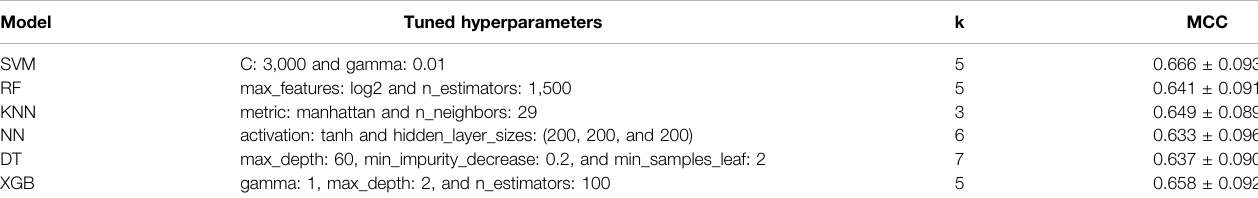
TABLE 2 | Tuned hyperparameters, k in the SMOTE, and the training performance of six machine learning models. Model Tuned hyperparameters k MCC SVM C: 3,000 and gamma: